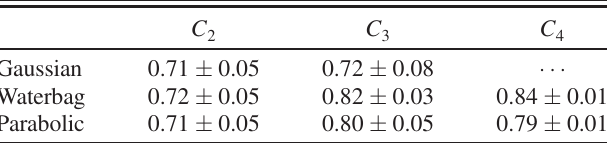
TABLE II. Coherent tune-shift factors estimated from sum resonance bands excited by skew multipole fields.